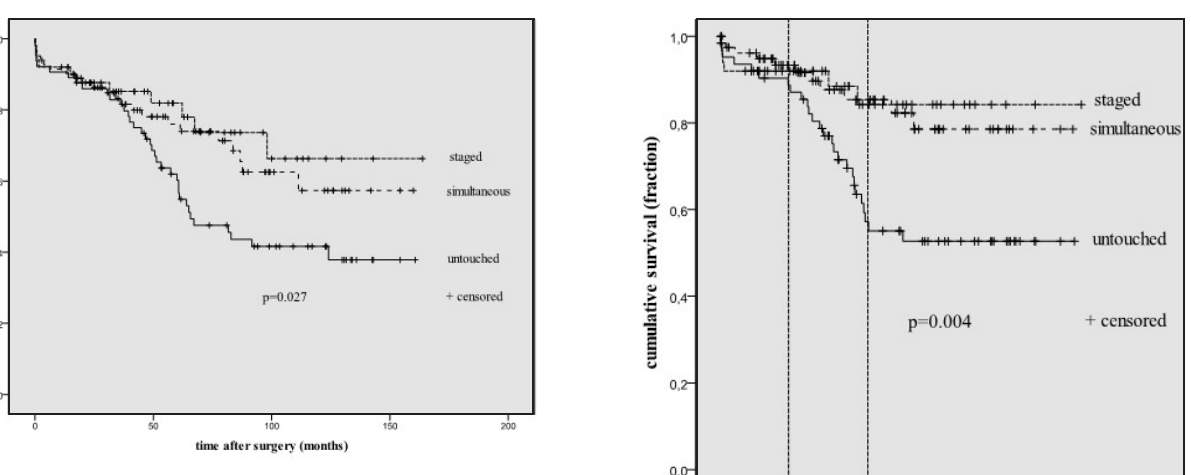
Fig. 1 - Event-free actuarial survival functions in the groups.